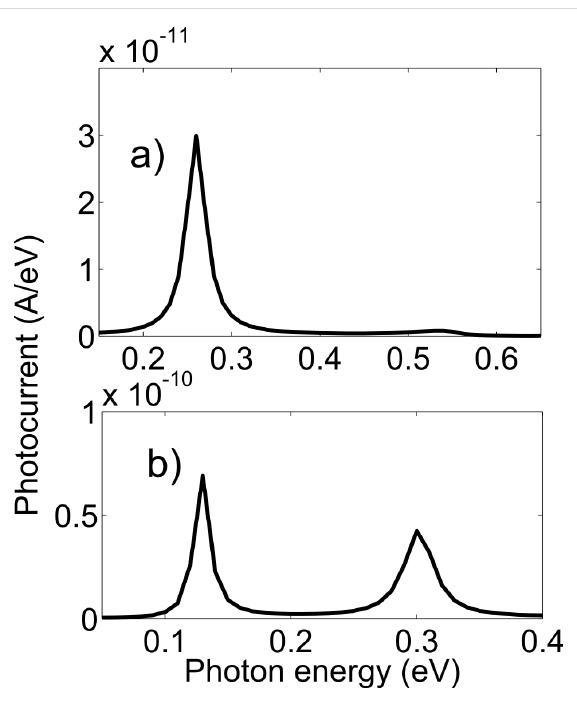
Figure 8: Variation of the peak photocurrent with photon energy. (a) Zigzag structure, (b) armchair structure.